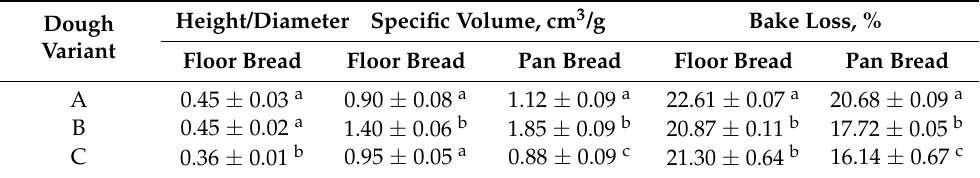
Table 6. Baking characteristics of nongluten dough